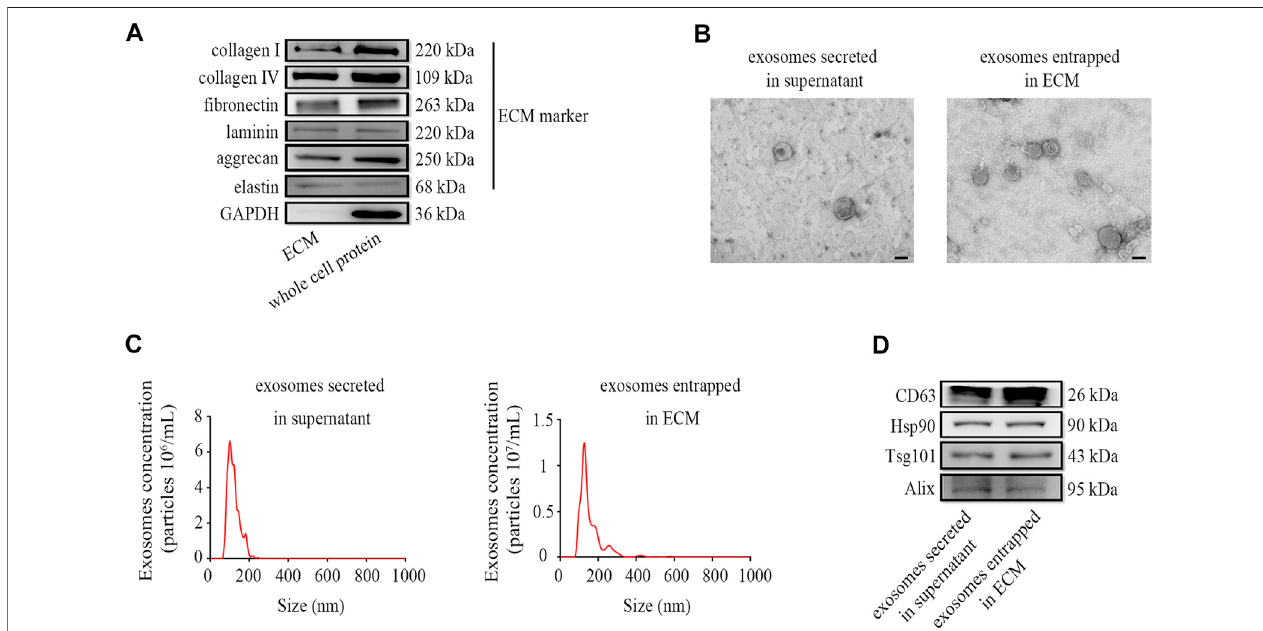
FIGURE 3 | Preparation and characterization of exosomes enriched in ECM. (A) The markers of liquid ECM were determined by Western blot. (B) TEM images for exosome morphology. (C) NTA analysis of particle size, and (D) Western blot analysis for exosomal markers of exosomes entrapped in ECM from HFF-CBD-Lamp2b cells and those secreted in supernatant from HFF cells. Scale bar (cid:1) 100